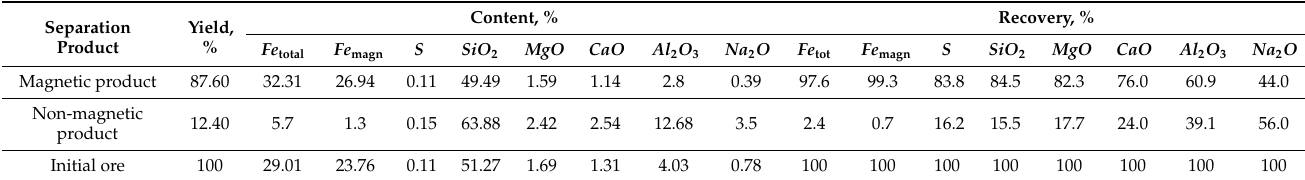
Table 4. Results of dry magnetic separation of an iron ore sample, Kostomuksha deposit.